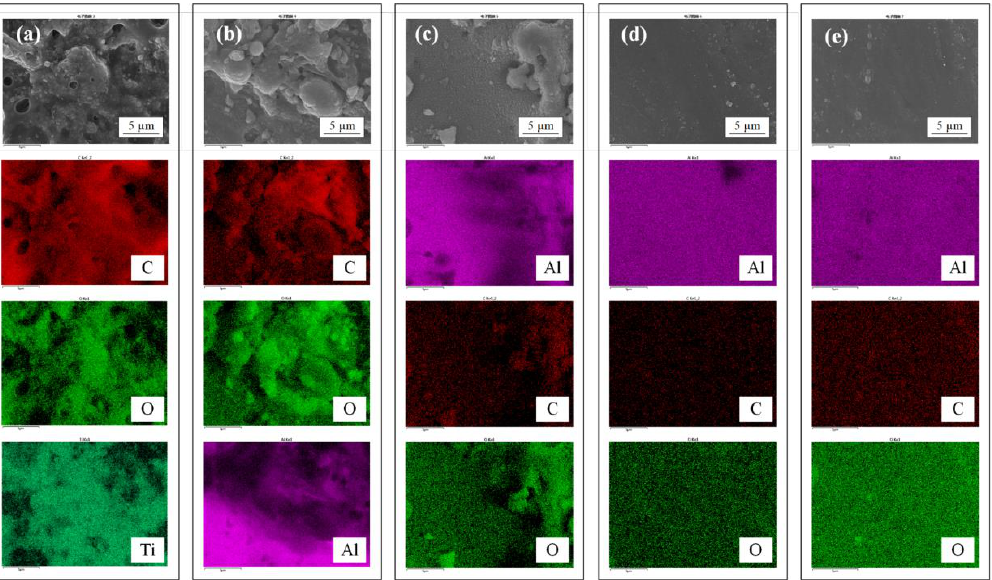
Figure 6. Distribution diagrams of the first three elements with the largest proportion on the laser- cleaned sample surface: ( a ) sample 2, ( b ) sample 3, ( c ) sample 4, ( d ) sample 5, ( e ) sample 6.